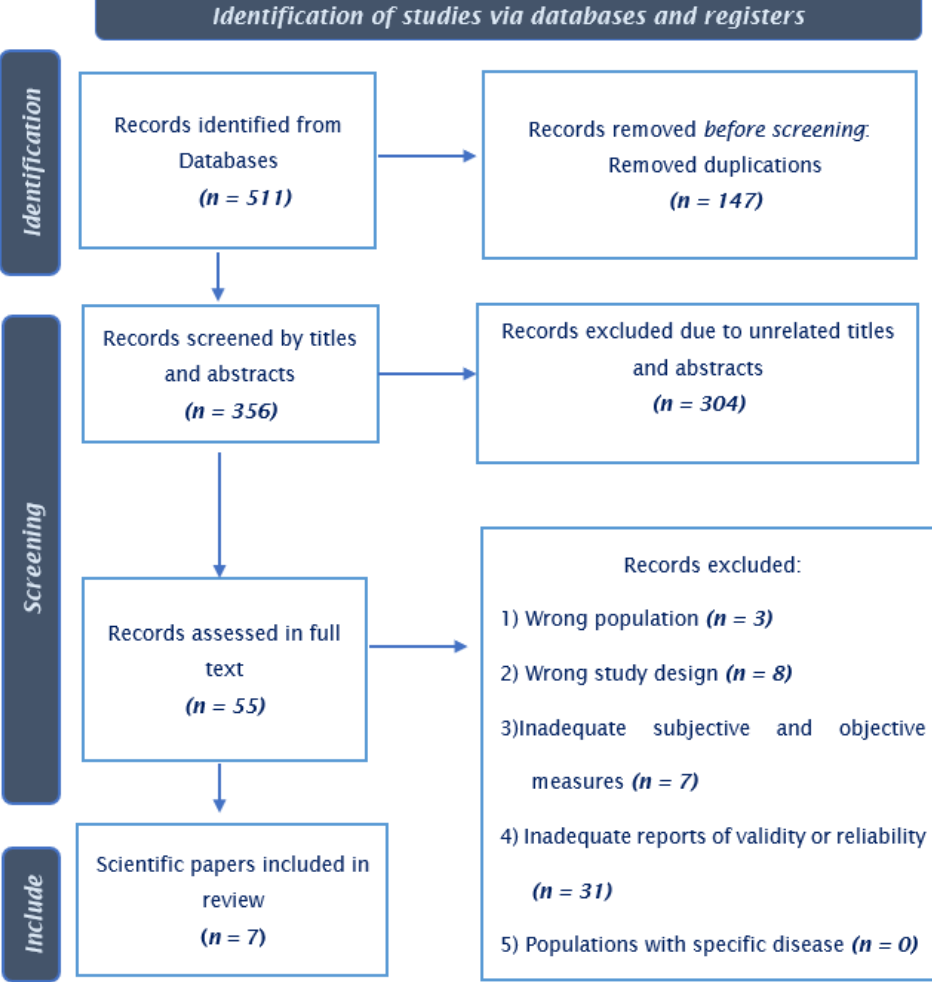
Figure 1. Flow diagram of systematic review process.